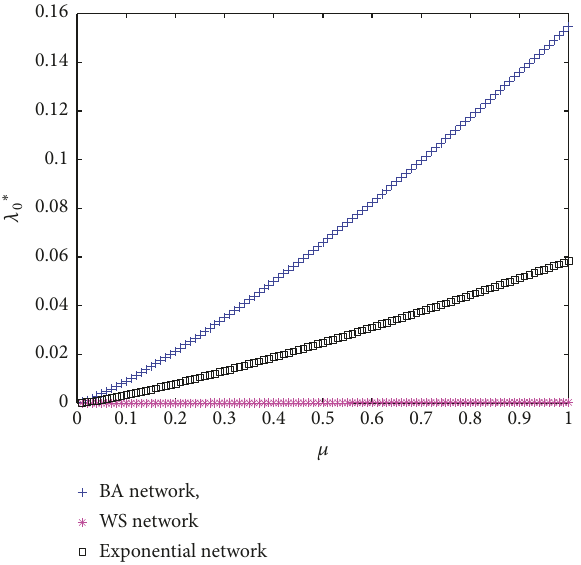
Figure 6: Effects of the recovery rate 𝜇 of health food consumers on the threshold 𝜆 0 ∗ of the rate of health food safety scare behavior diffusion under three network structures (where 𝜃 = 0.5 , 𝜂 𝑘 = 0.7 , and 𝑘 = 1000